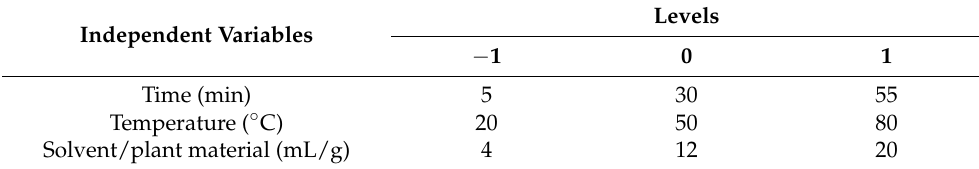
Table 3. Factors and relative levels applied to the experimental